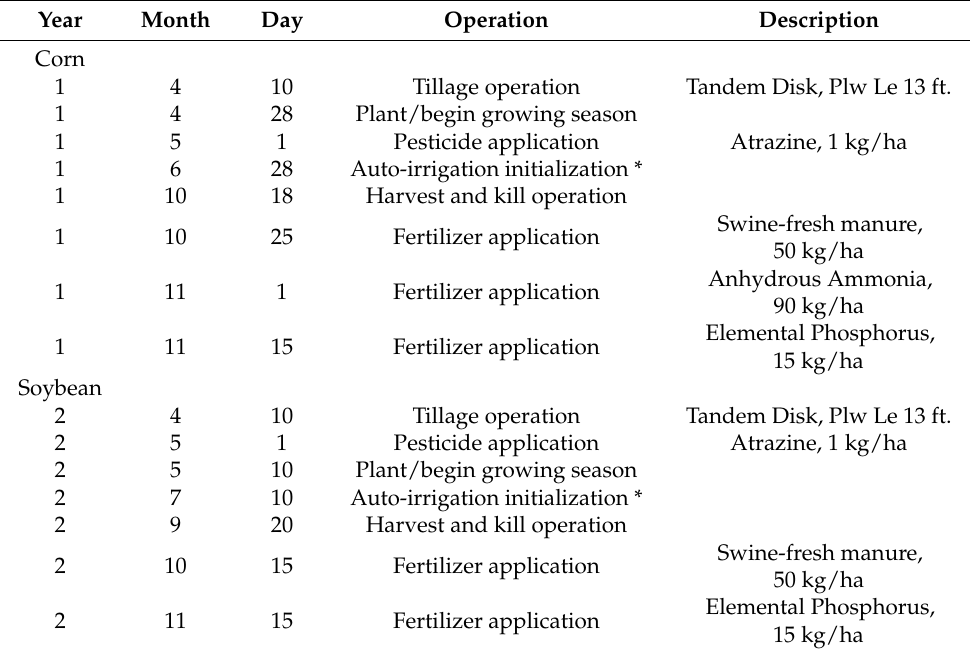
Table 2. Scheduled management operations in the Shell Creek